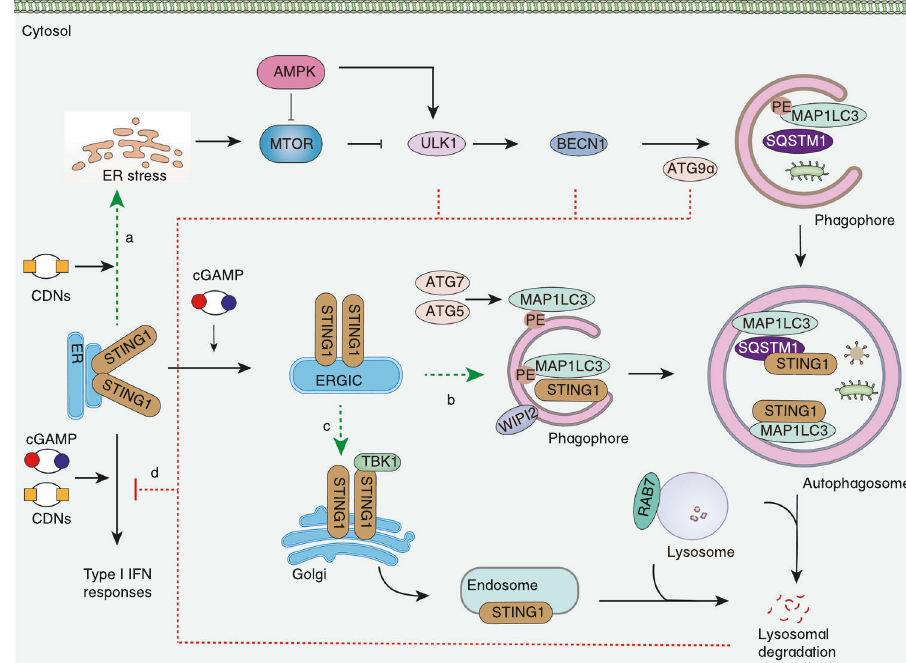
Fig. 2 Crosstalk between STING1 and autophagy. a The activation of STING1 by bacterial CDNs triggers autophagy through ER stress or the MTOR-ULK1-BECN1 pathway. b cGAMP binds to STING1, causing it to be translocated from the ER to the ERGIC and Golgi. The ERGIC serves as a membrane source for the recruitment and lipidation of MAP1LC3 through an ATG5-, ATG7-, and WIPI2-dependent mechanism, leading to autophagosome formation. Autophagosomes engul fi ng DNA and pathogens target STING1 in an SQSTM1-dependent or -independent manner. c Activated STING1 can translocate to endosomes through the trans-Golgi network. Both the endosomes and autophagosomes fused with lysosomes require RAB7A GTPase. d STING1-mediated IFN response is also negatively regulated by autophagic degradation or ATGs (including ULK1, BECN1, and ATG9a). AMPK AMP-activated protein kinase, ATG autophagy-related, BECN1 beclin 1, CDNs cytosolic cyclic dinucleotides, cGAMP cyclic GMP-AMP, ER endoplasmic reticulum, ERGIC endoplasmic reticulum-Golgi intermediate compartment, IFN interferon, MAP1LC3 microtubule-associated protein 1 light chain 3, MTOR mechanistic target of rapamycin kinase, PE phosphatidyletha- nolamine, PIK3C3 phosphatidylinositol 3-kinase catalytic subunit type 3, RAB7A, member RAS oncogene family, SQSTM1 sequestosome 1, STING1 stimulator of interferon response cGAMP interactor 1, TBK1 TANK binding kinase 1, ULK1 unc-51 – like autophagy activating kinase 1, WIPI2 WD repeat domain phosphoinositide-interacting